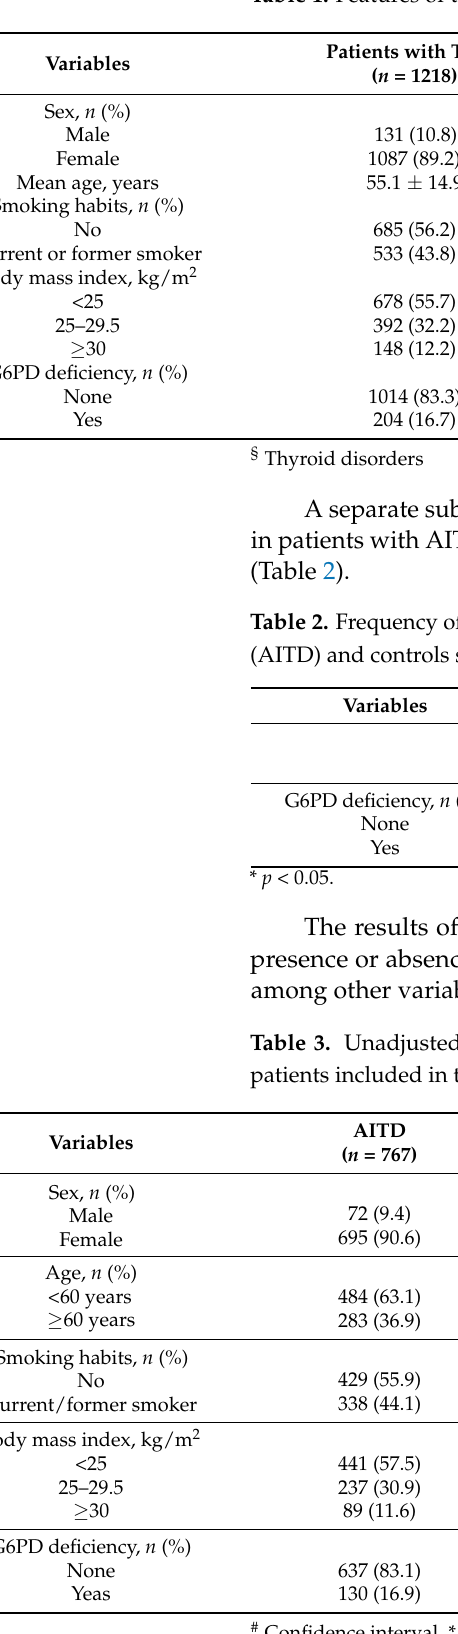
Table 1. Features of the 8894 study participants with and without TDs.